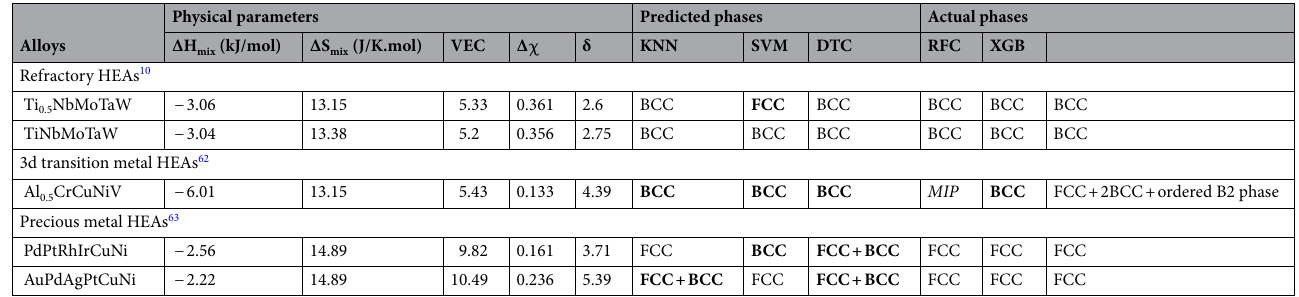
Table 2. Validation of all vanilla (base) model’s performance for unseen compositions (not used in training or test datasets). Phases shown in bold font indicate the wrong prediction, italic font shows an exceptional case, and the remaining (nonbold and nonitalic) indicate the correct